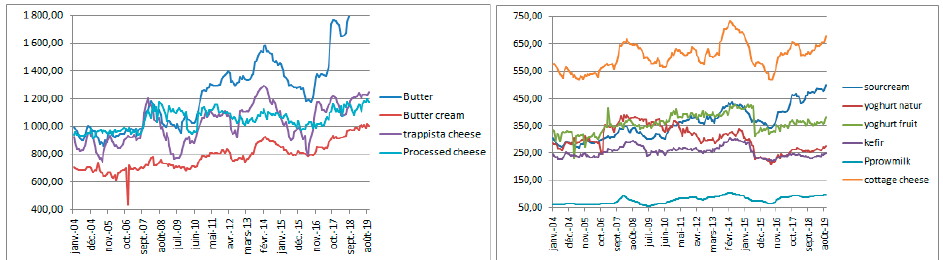
Figure 1. Prices of milk products in Hungary (in HUF). Source: Research Institute of Agricultural Economics [28].